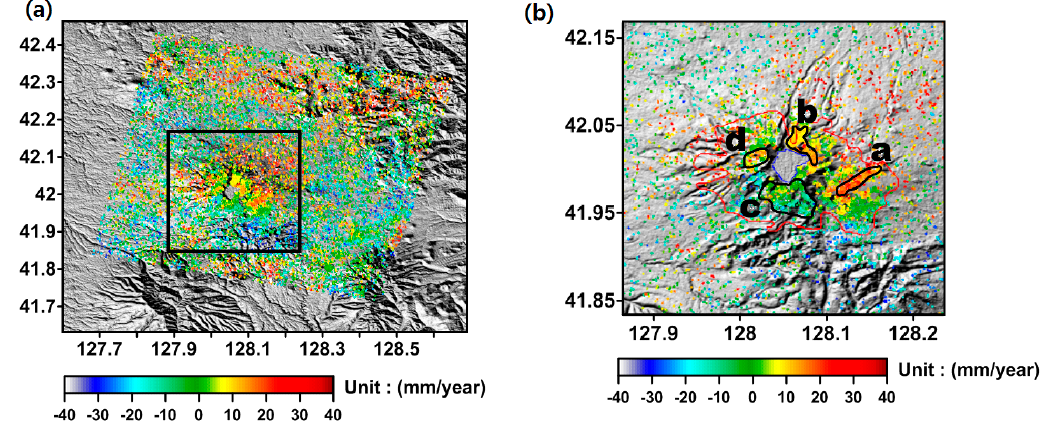
Figure 7. Mean velocity in Line of Sight (LOS) direction over Mt. Baekdu during 2007/02/02–